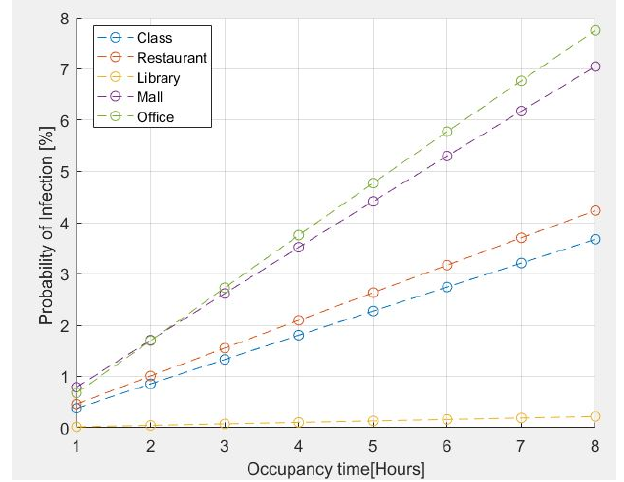
Figure 4. Probability of infection for some common environments vs. occupancy time.